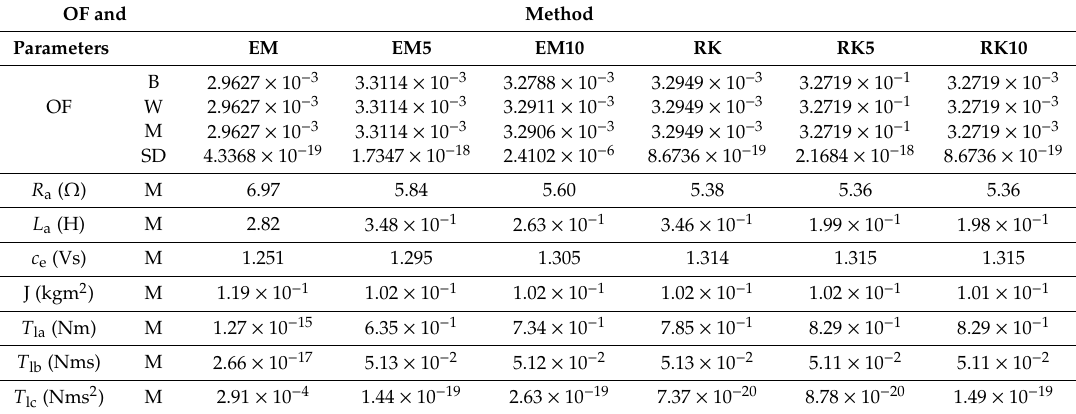
Figure 21. Measured and calculated responses in the case of MD3 using: ( a ) EM10; ( b ) RK10. Comparing Figures 10 and 21, especially the improvement achieved with EM10 can be seen. OF and mean values of the calculated parameters using EM, EM5, EM10, RK, RK5, and RK10 for MD4 are shown in Table 27. Table 27. OF and Mean value of the calculated parameters for 50 independent runs using EM, EM5, EM10, RK, RK5, and RK10 for MD4.